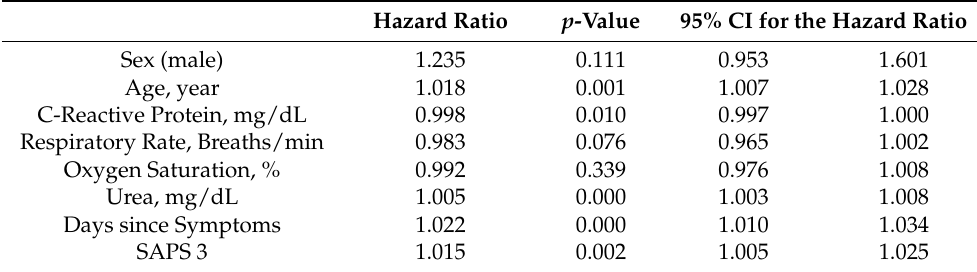
Table 2. Hazard ratio multivariable Cox mode.